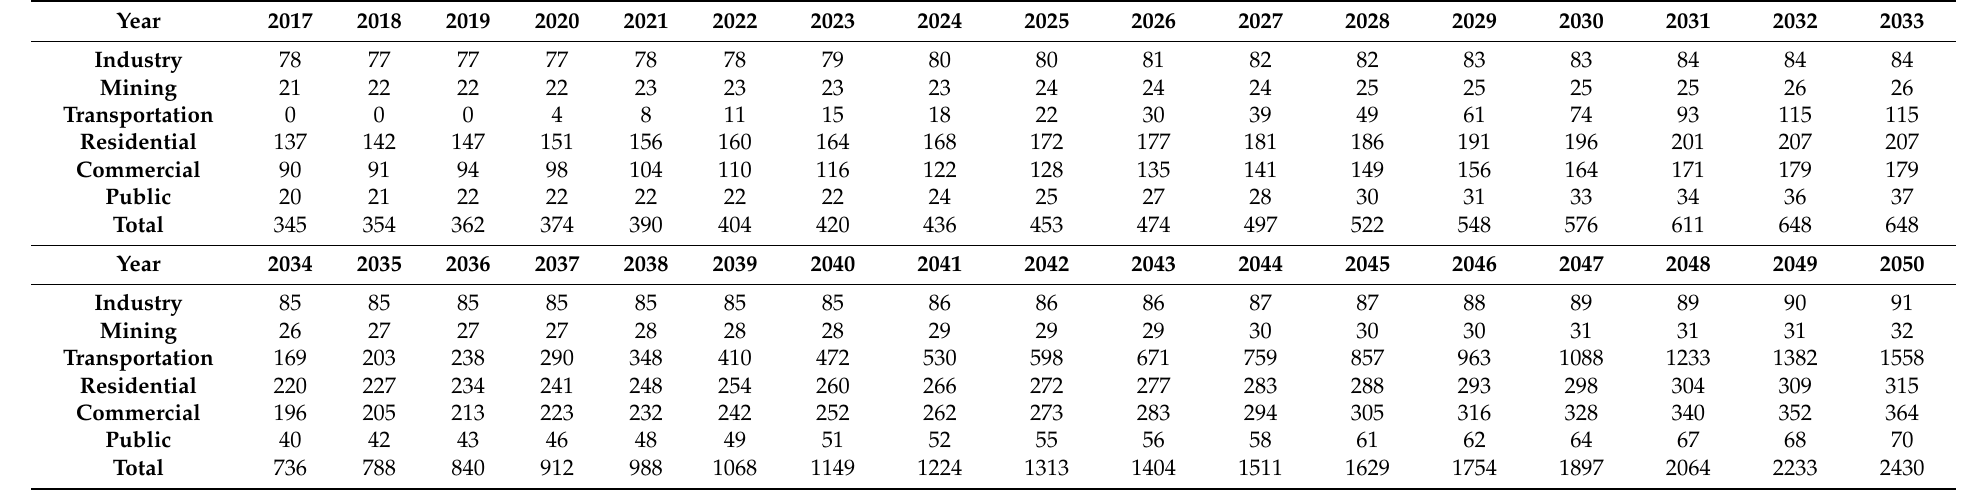
Table 4. Projected electricity demand in the region of Arica and Parinacota for different sectors 2017 to 2050